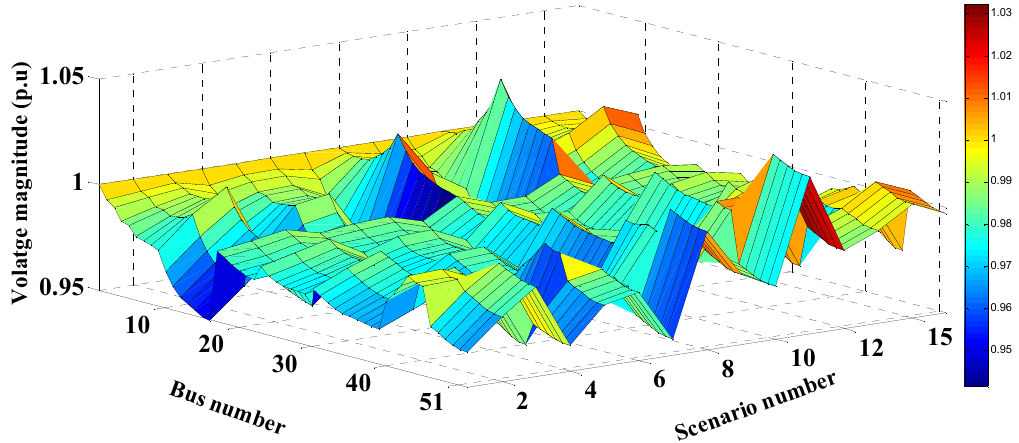
Figure 19. Bus voltage magnitudes of the 51-bus system with RERs. Table 9. The statistical results in the rural 51-bus system with the use of several optimizers. Table 8. The 51-bus system simulation results. Optimizer Best